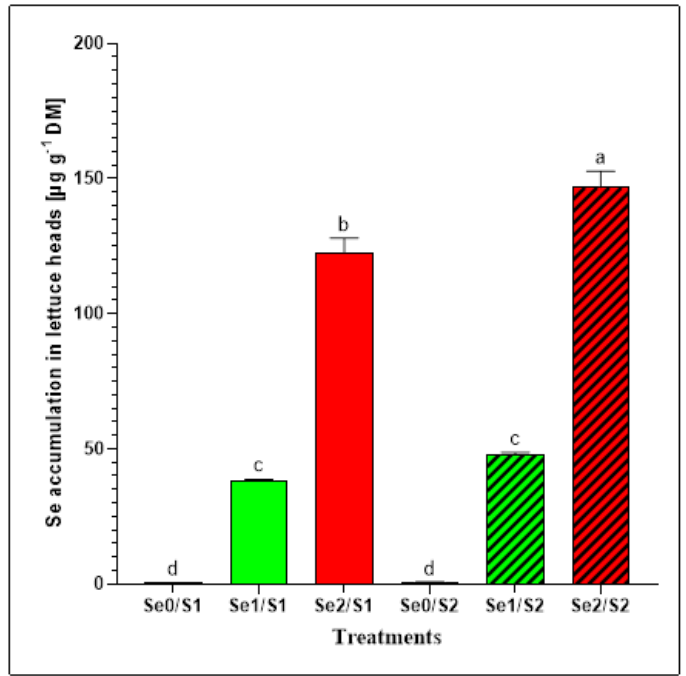
Figure 3. Se accumulation in the lettuce plants grown in a hydroponic system and treated with two S levels (S1: 1 mM; and S2: 2 mM (K 2 SO 4 )), and three Se levels (Se0: 0 µM; Se1: 1.3 µM; and Se2: 3.8 µM (Na 2 SeO 4 )). The data presented are the means ± SE of four replicates. Different letters show statistically significant differences among all the treatments ( p ≤ 0.05; Tukey’s test).